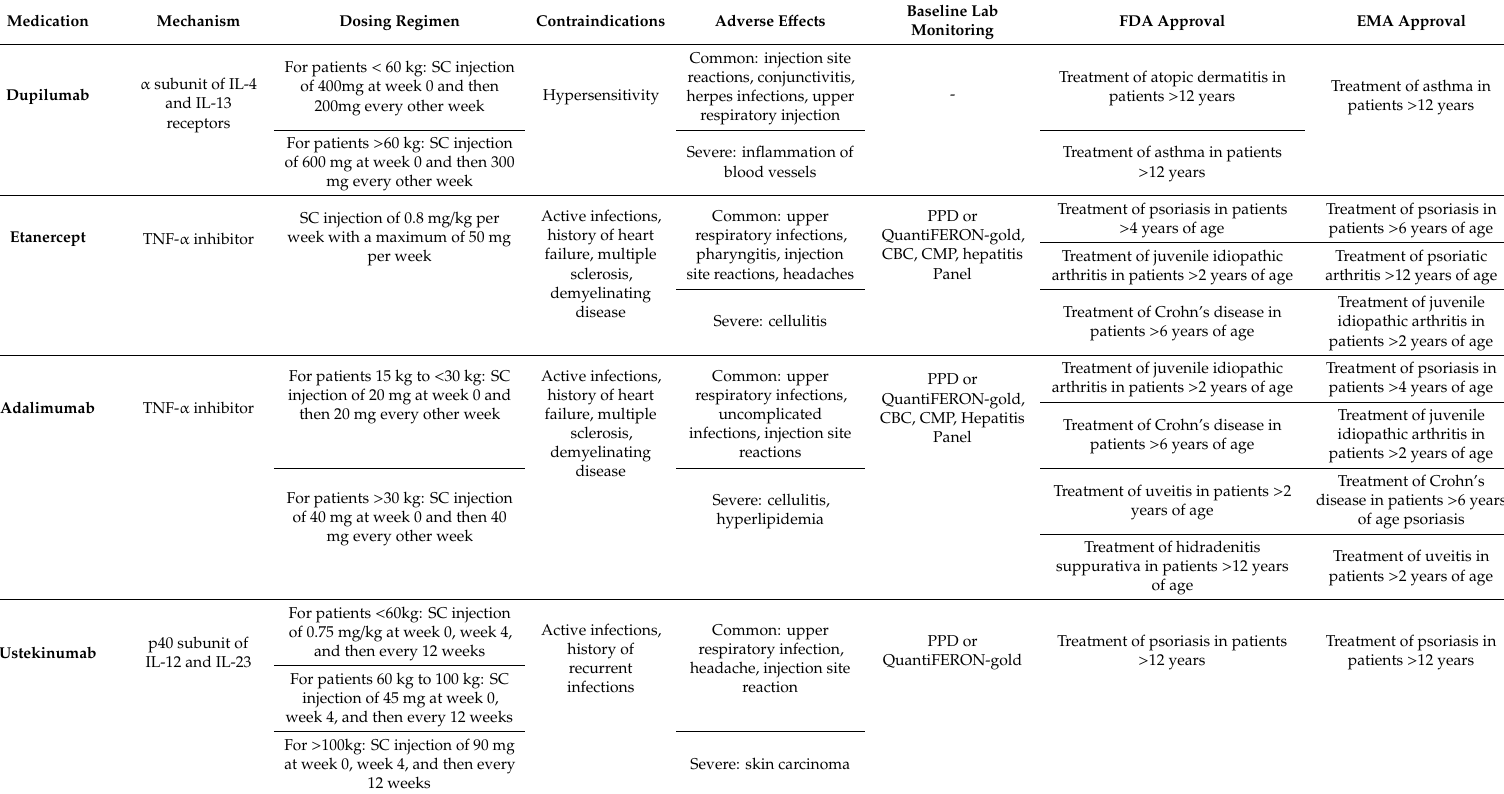
Table 1. Food and Drug Administration (FDA)- and European Medicines Association (EMA)-approved biologic treatments in pediatric patients with atopic dermatitis or